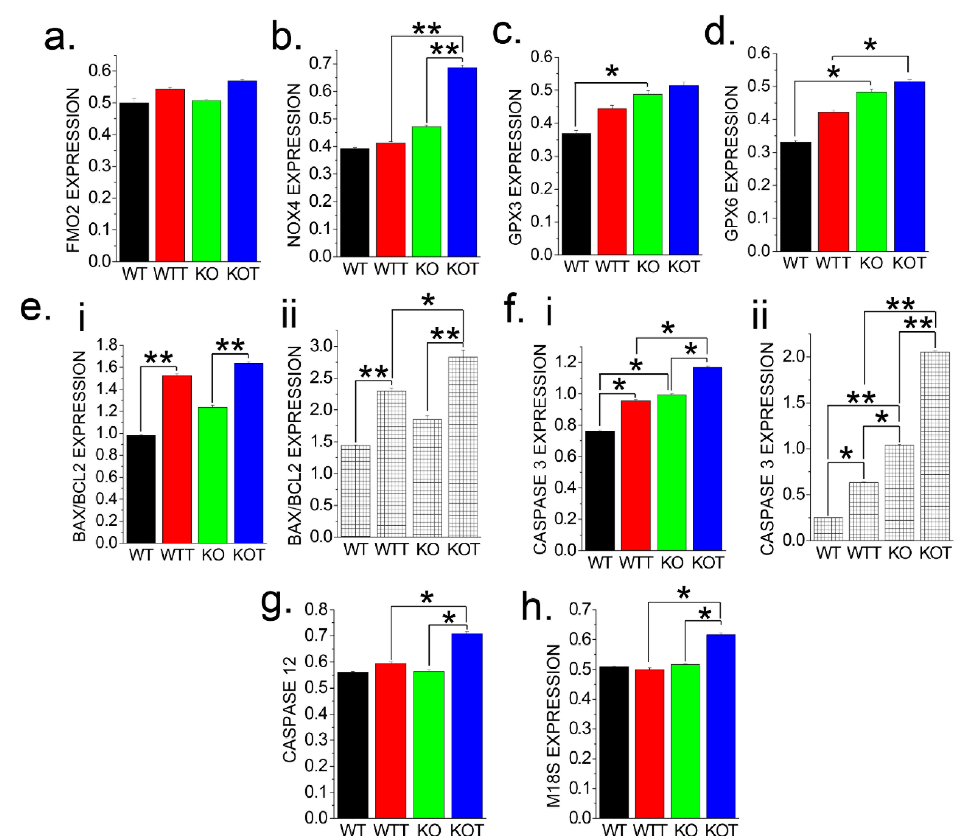
Figure 7. Higher luminal pH induced by Acz increases oxidative stress and promote ER stress-induced apoptosis. Genetic expressions of oxidative stress markers ( a ) FMO2 and ( b ) NOX4, were assessed among WT, WTT, KO and KOT mice PT cells, which show oxidative stress gene, NOX4, expression was significantly increased in the KOT groups compared to all other groups analyzed. ( c ) GPX3 and ( d ) GPX6, markers for protection from oxidative stress, were significantly higher the KOT group compared to all other groups analyzed. Genetic and protein expression for apoptotic markers ( ei , eii ) BAX/BCL2 and ( fi , fii ) Caspase 3 and ( g ) Caspase 12 were significantly higher for all treated groups especially for KOT group compared to the controls (WT and KO). Evidence of endoplasmic reticulum (ER) stress following Acz treatment through genetic expression levels ER stress marker ( h ) M18S, assessed for WT, WTT, KO, and KOT mice PT cells where the ER stress gene was significantly expressed in the KOT group compared to all other groups analyzed. Experiments were performed three times. ( a–h ) Bar graphs are means ± SEM. *, p < 0.05; **, p < 0.01. All gene and protein expressions are normalized to GAPDH and β-Actin respectively.